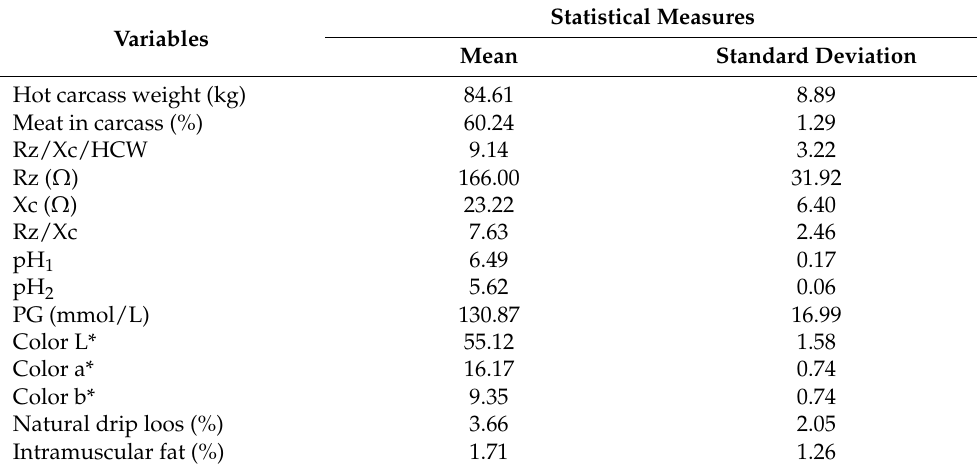
Table 1. Group characteristics of animals (BIA was carried out on livestock n =